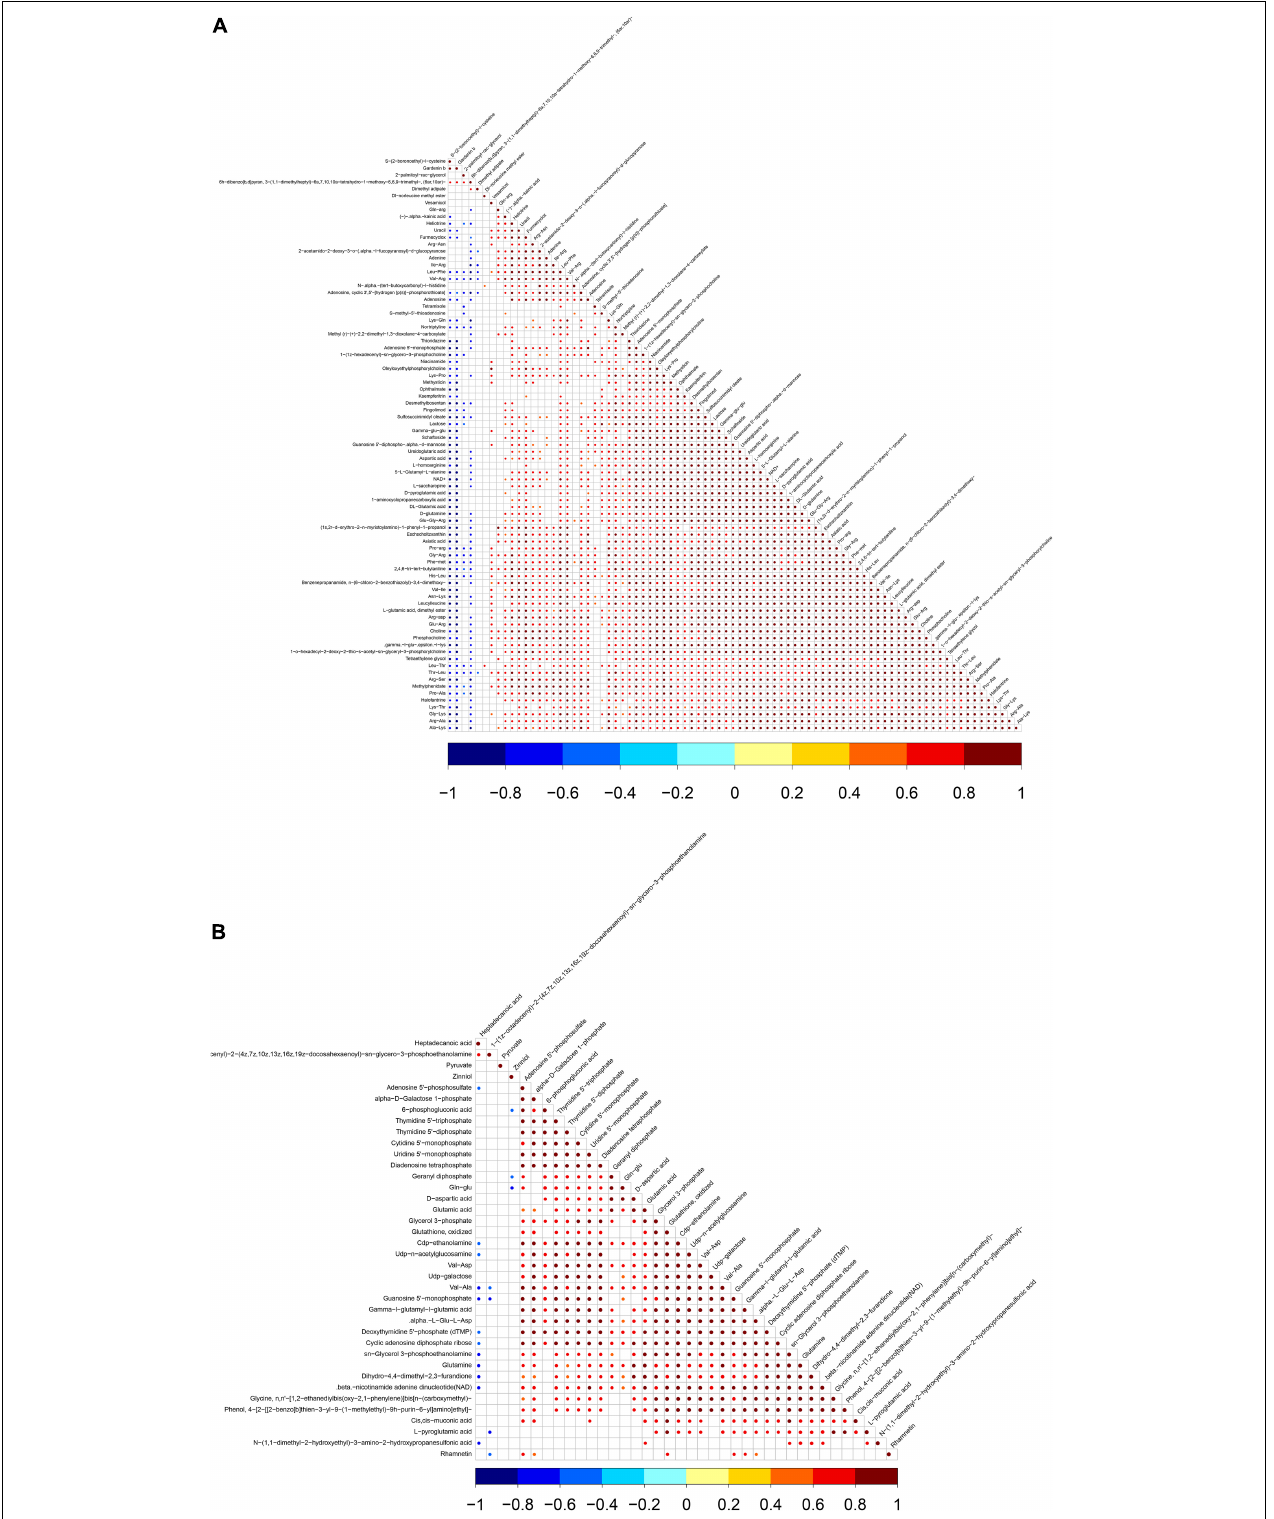
FIGURE 5 | Pearson’s of differentially expressed metabolites in positive ion mode (A) and negative ion mode (B) . Red indicates positive correlation, blue indicates negative correlation, and white indicates no significant correlation. The color depth is related to the absolute value of correlation coefficient. The higher the degree of positive correlation or negative correlation, the darker the color. The size of the point is related to the significance of the correlation, the more significant.